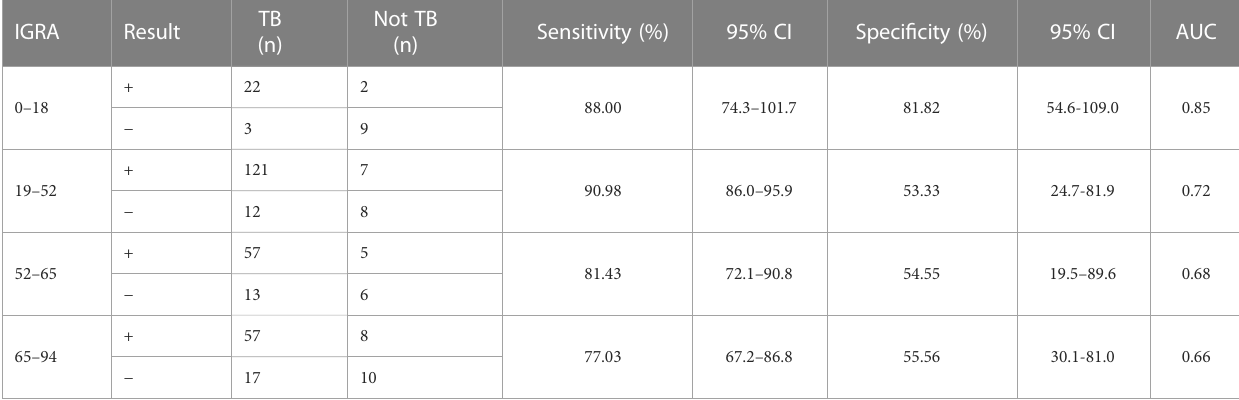
TABLE 6 Comparison of the accuracy of IGRA test in patients of different ages with clinically diagnosed tuberculosis.